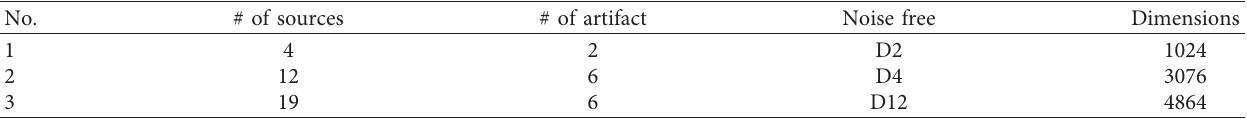
Table 10: Description of the six datasets.